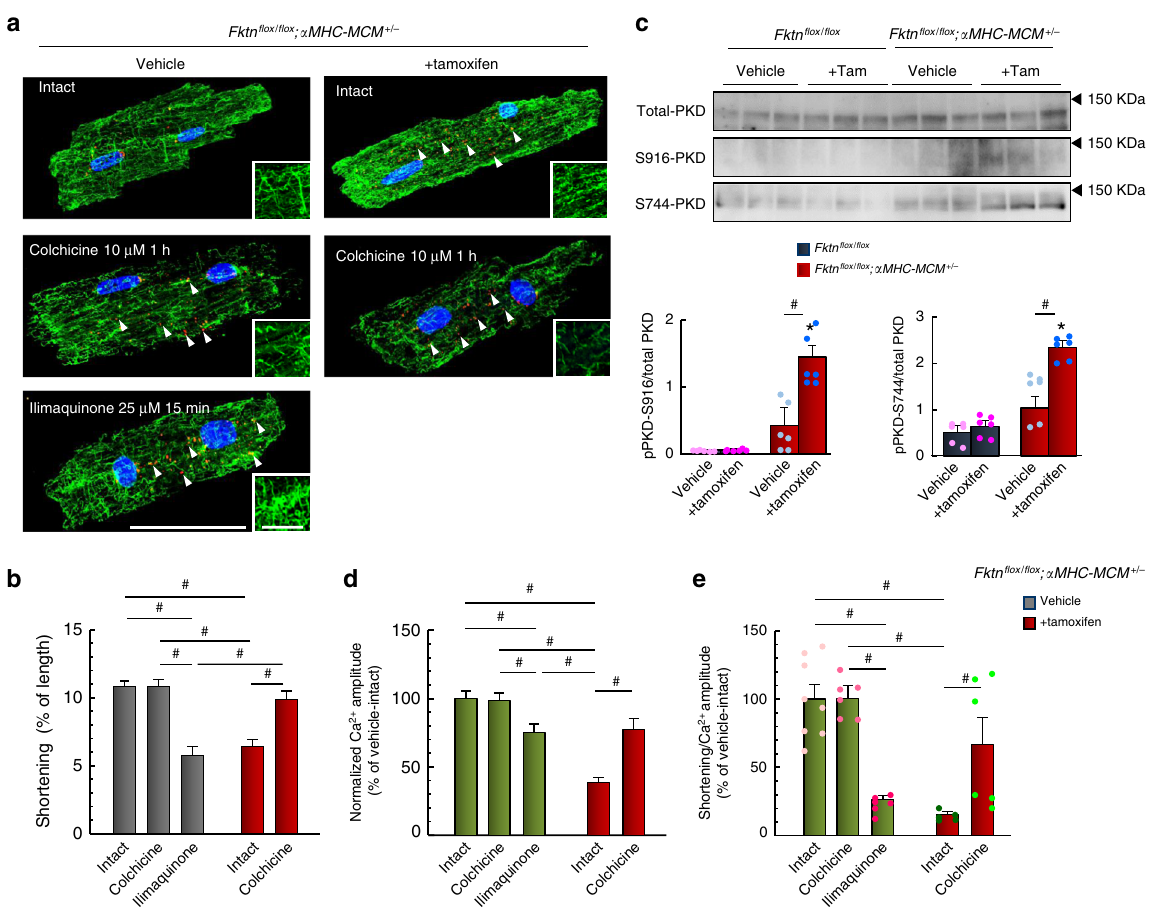
Fig. 8 MT densi fi cation and fragmentation of Golgi in α MHC-MCM- Fktn -cKO ( Fktn fl ox/ fl ox ; α MHC-MCM + / − ) myocytes. a Representative immuno fl uorescence images for MT (green) and GM130 (red) staining. Arrowheads show abnormally distributed GM130 signals. Scale bar, 50 μ m (insets, 10 μ m). b Electrical stimulation-induced (1 Hz) myocyte shortening (vehicle-intact, n = 101 cells from 5 mice; vehicle-colchicine, n = 40 cells from 4 mice; vehicle-ilimaquinone, n = 20 cells from 3 mice, tamoxifen-intact, n = 29 cells from 3 mice; tamoxifen-colchicine, n = 40 cells from 3 mice). c Representative images of immunoblots. Phosphorylation level of PKD is shown relative to total PKD ( n = 6 mice per group). * P < 0.05 vs. vehicle-treated fl oxed mice; # P < 0.05 between indicated groups based on Tukey – Kramer tests. d Normalized peak amplitudes (vehicle-intact, n = 32 cells from 4 mice; vehicle-colchicine, n = 39 cells from 3 mice; vehicle-ilimaquinone, n = 26 cells from 3 mice, tamoxifen-intact, n = 14 cells from 4 mice; tamoxifen- colchicine, n = 11 cells from 4 mice). e Contractile ef fi ciency (vehicle-intact, n = 8 cells; vehicle-colchicine, n = 6 cells; vehicle-ilimaquinone, n = 6 cells, tamoxifen-intact, n = 5 cells; tamoxifen-colchicine, n = 6 cells from 3 mice per group). # P < 0.05 between indicated groups based on Tukey – Kramer tests ( b , d , e